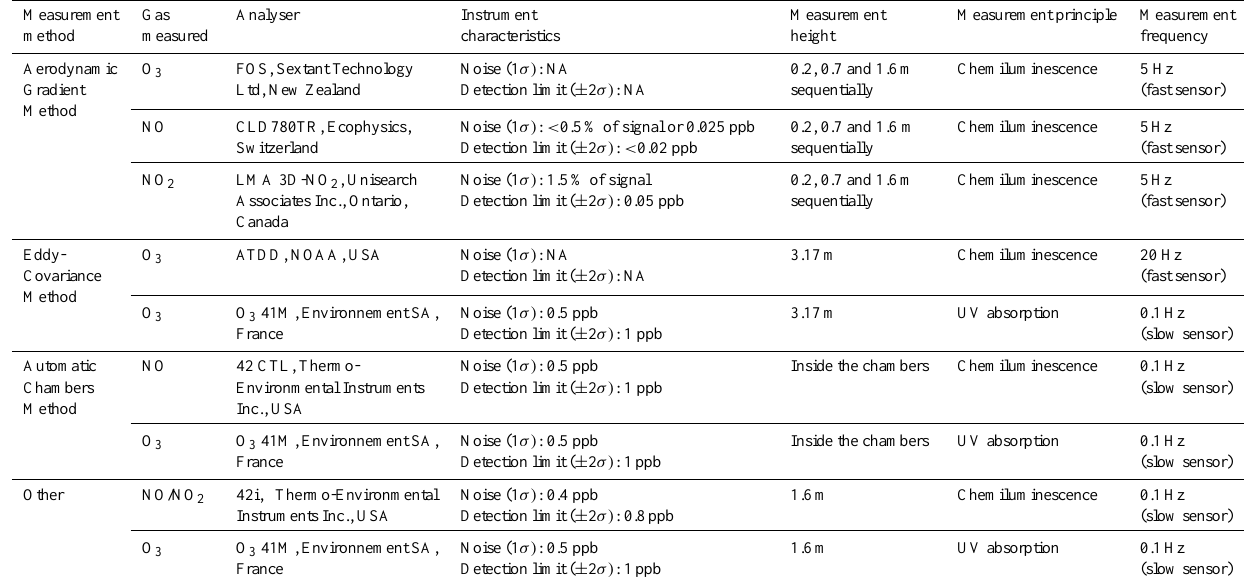
Table 1. Instruments used for O 3 -NO-NO 2 measurements. The instrument characteristics are those given by the manufacturers. Measurement